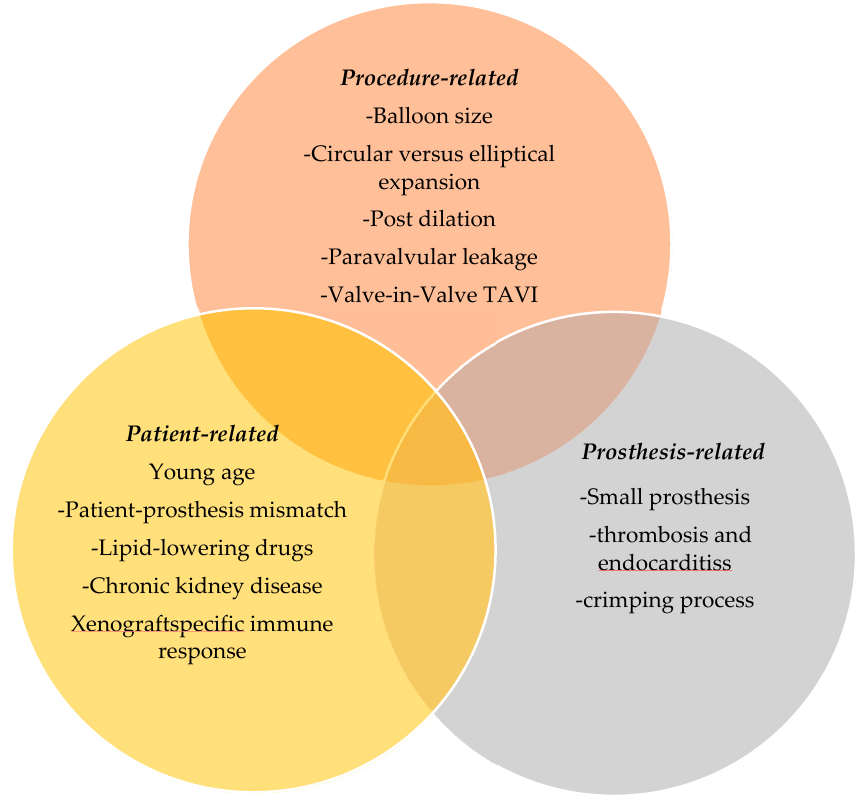
Figure 4. Patient-, prosthesis- and procedure-related factors involved in degeneration of bioprosthetic valves in stents.